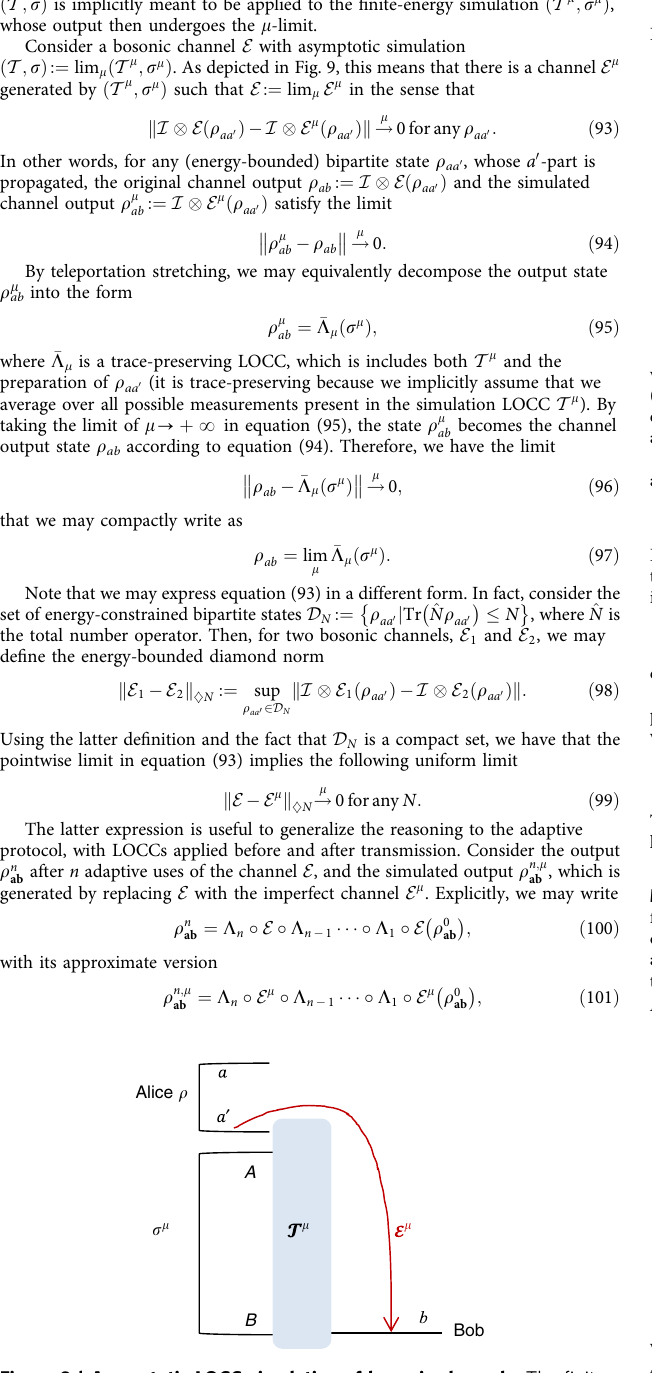
Figure 9 | Asymptotic LOCC simulation of bosonic channels. The finite- energy LOCC simulation T m ; s m ð Þ generates a teleportation channel E m